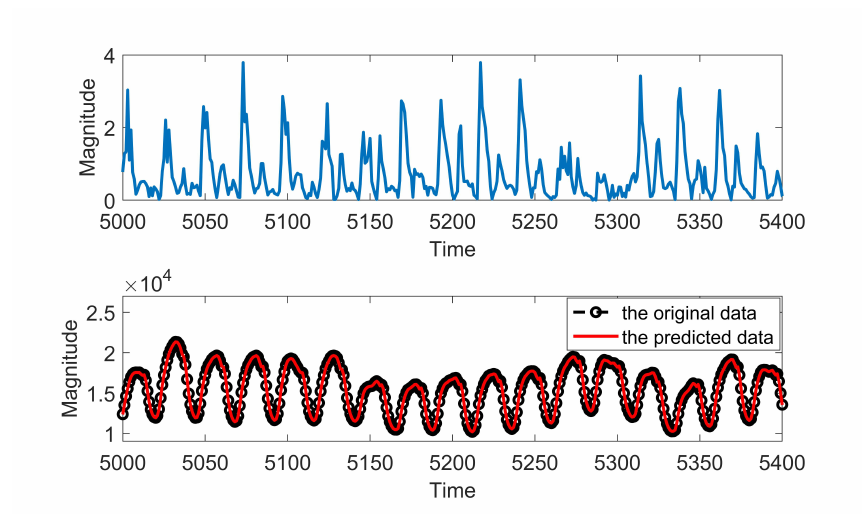
Figure 5. The total load prediction results and absolute error curves of the exploited LF-NSNP mode.